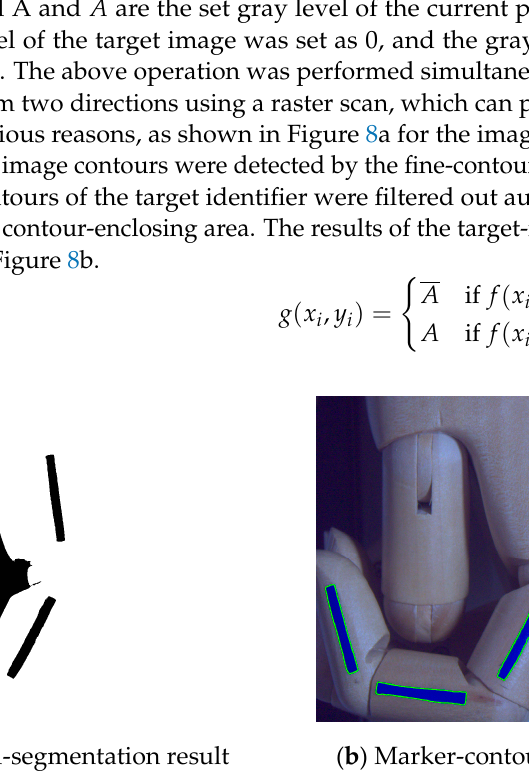
8 of 16 Figure 6. Grayscale conversion of the original image with the histogram. (2) Image thresholding method with edge-contour extraction The use of image segmentation to separate the target region from the background region can prevent the need to conduct a blind search on the image and greatly improve the processing efficiency of the image [24,25]. Threshold segmentation based on the gray- scale histogram is simple to compute and is suitable for grayscale images where the target and background are distributed in different grayscale ranges, as shown in Figure 7 for the histogram of the original image.